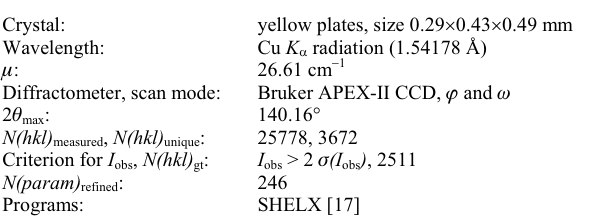
Table 1. Data collection and handling.